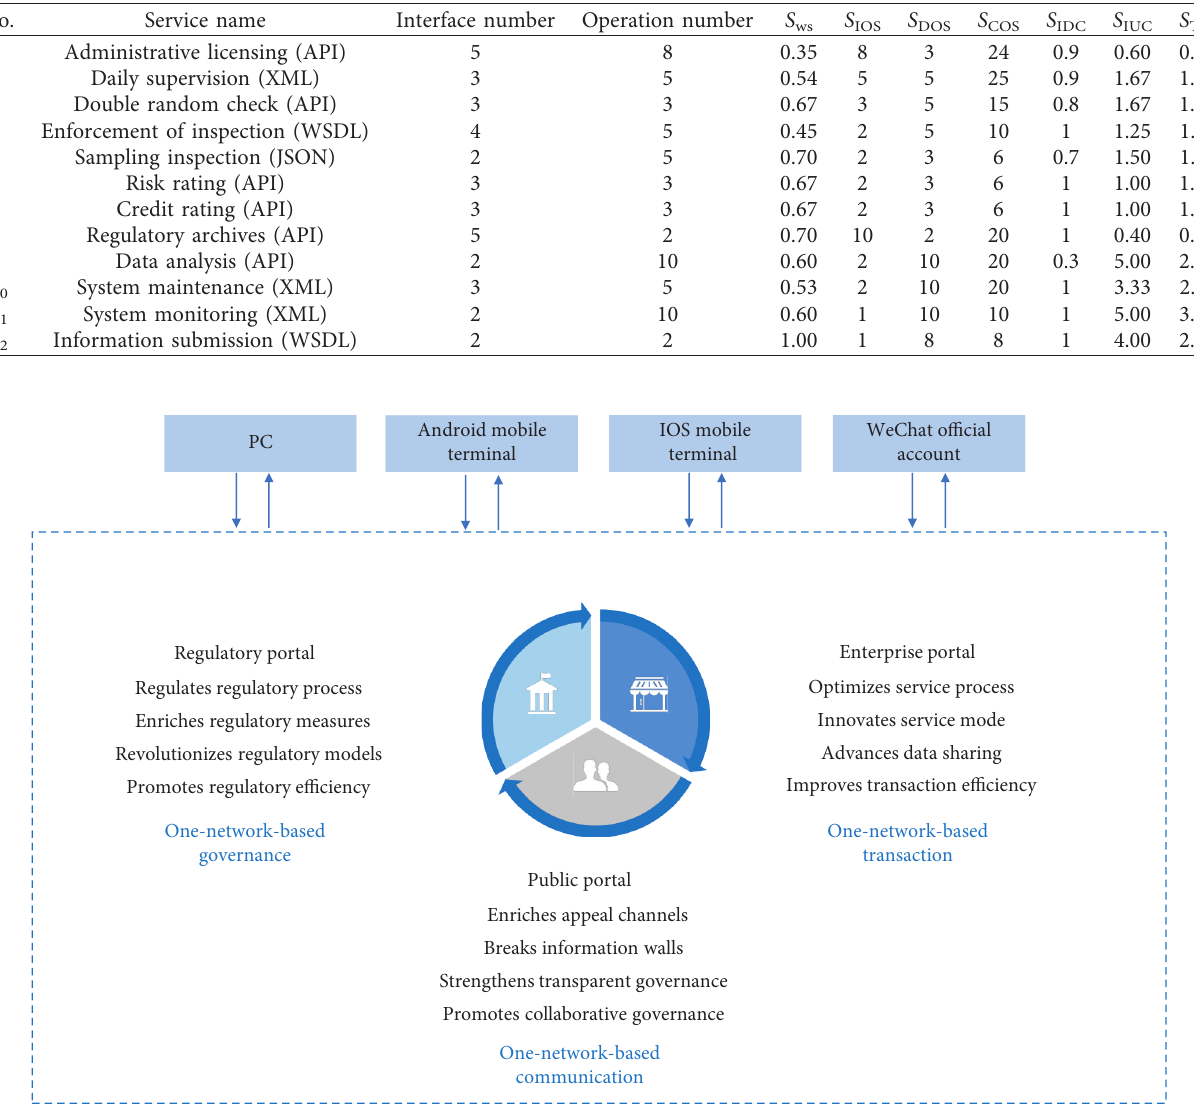
Table 2: Calculation results of the maintainability